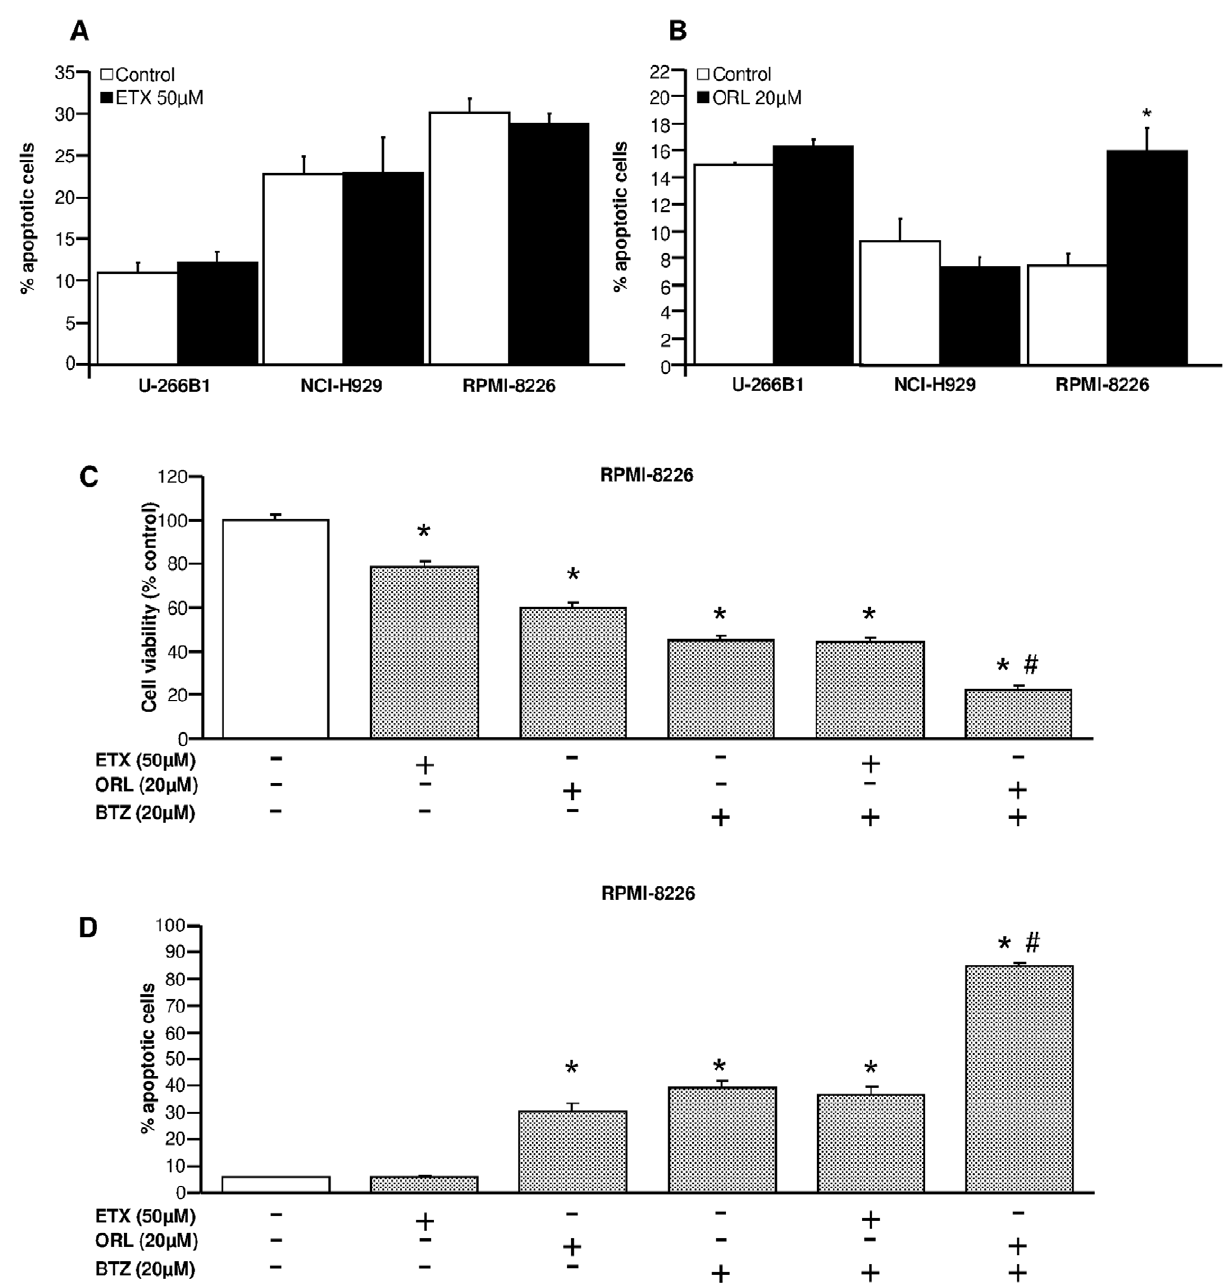
Figure 4. Orlistat enhances the apoptotic effect of bortezomib in RPMI-8266 cells. The effect of etomoxir ( A ) or orlistat ( B ) on apoptosis in U-266B1, NCI-H929 and RPMI-8226 cells was determined by FACS analysis of intracellular cleaved-caspase-3 levels. Cells were preincubated in the presence or absence of 50 m M etomoxir or 20 m M orlistat for 18 h and 24 h respectively, and cleaved-caspase-3 levels were analyzed as described in the ‘‘Materials and Methods’’ section. Results are means 6 SEM for 3 independent experiments in triplicate. *p , 0.05 versus untreated cells. ( C ) The effect of etomoxir, orlistat or bortezomib on cell viability was analyzed in RPMI-8226 cells. Cells were preincubated in the presence or absence of 50 m M etomoxir, 20 m M orlistat or 20 m M bortezomib for 24 hours. Afterwards, cell viability was determined as described in the ‘‘Materials and Methods’’ section. Results are means 6 SEM for 6 independent experiments in triplicate. *p , 0.05 versus untreated cells. # p , 0.05 versus orlistat or etomoxir alone. ( D ) The effect of etomoxir, orlistat or bortezomib on apoptosis was analyzed in RPMI-8226 cells. Cells were preincubated as described above. Afterwards, the percentage of apoptotic cells was determined by FACS analysis of intracellular cleaved-caspase-3 levels as described above. Results are means 6 SEM for 6 independent experiments in triplicate. *p , 0.05 versus untreated cells. # p , 0.05 versus orlistat or etomoxir